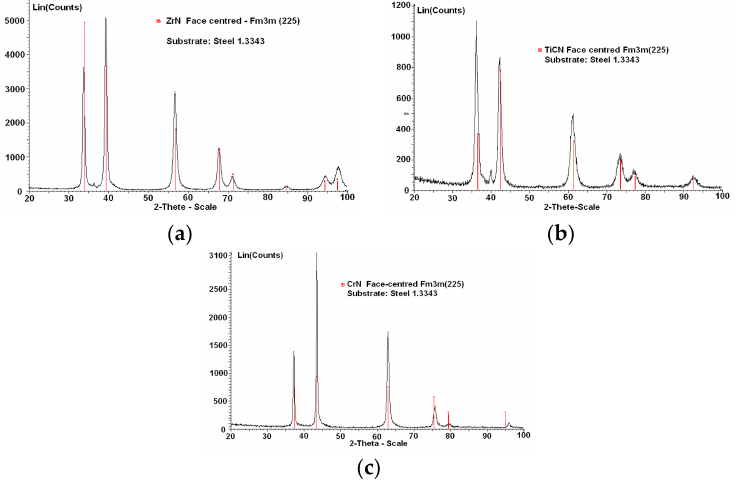
Figure 4. GI qualitative X-ray analysis: ( a ) ZrN-FCC-Fm3m (255); ( b ) TiCN MP-FCC-Fm3m (255) and ( c ) CrN-FCC-Fm3m (255). Table 2. Lattice parameters, size of phase crystals.